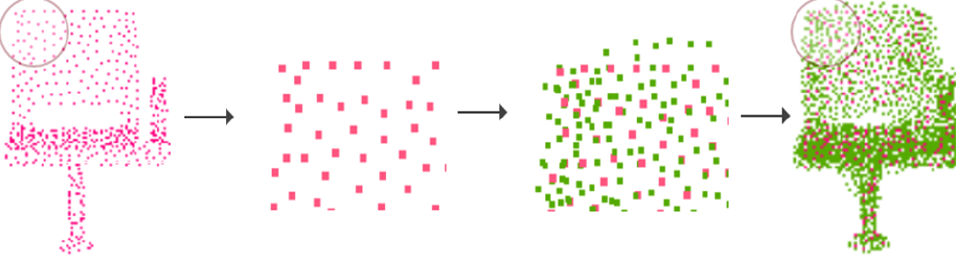
Figure 5. Blurring the boundaries of the chair. Where the red point cloud represents the original point cloud and the green point cloud represents the upsampling point cloud. We use the circles to select the boundary part of the chair to